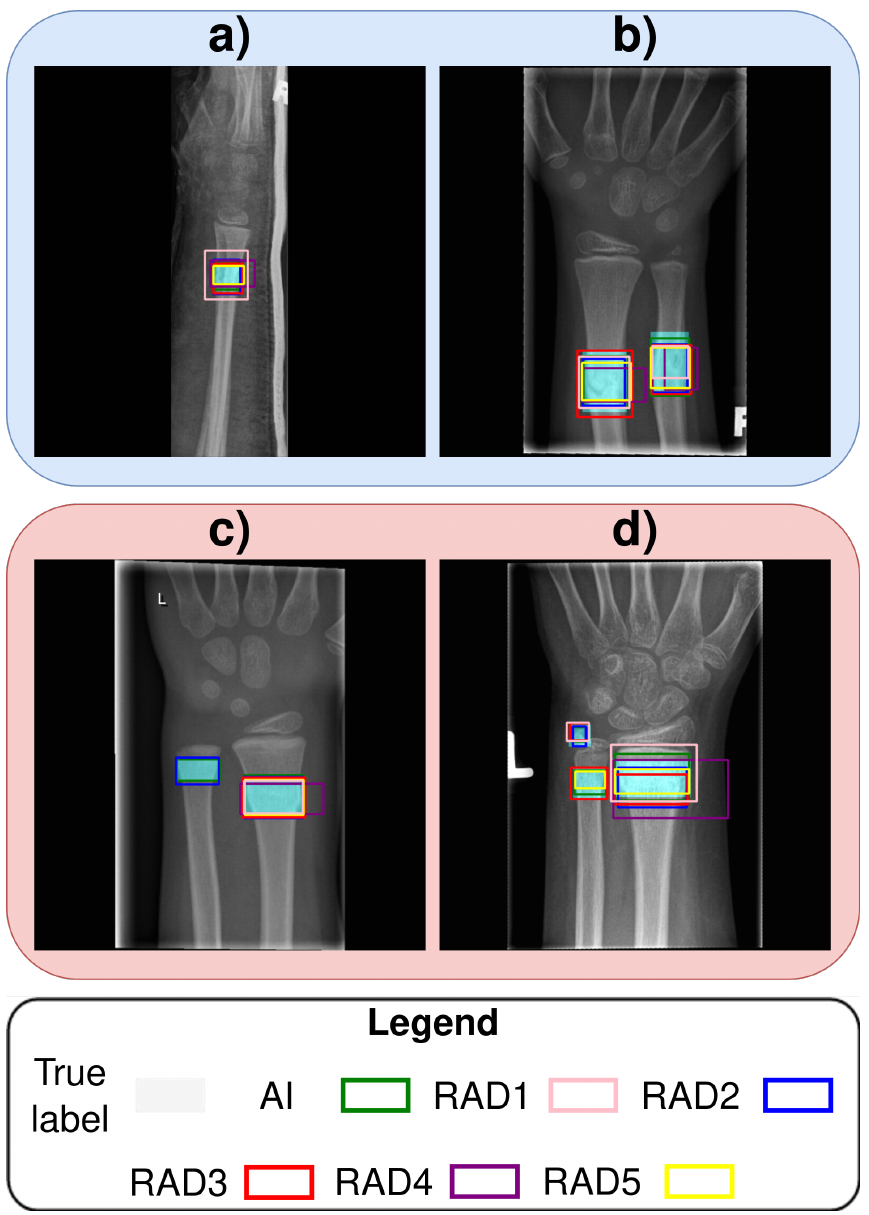
Figure 8. Examples of radiologists and AI fracture labels. In the legend, the labels are presented for every test subject. ( a , b ) Images where all test subjects marked the fractures correctly, while ( c , d ) show examples of images where some test subjects did not label all fractures